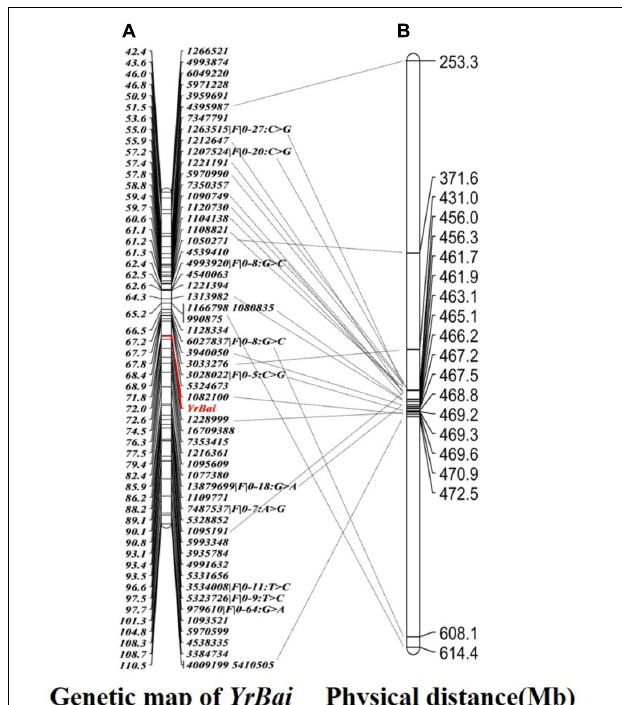
FIGURE 3 | High-density genetic map (A) and physical position (B) of the adult-plant resistance gene YrBai.